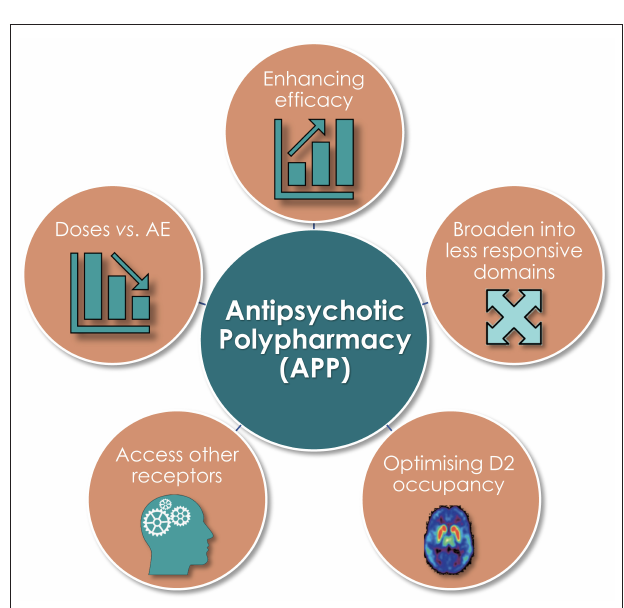
FIGURE 3 | Commonly given pharmacodynamically (PD)-based reasons to initiate